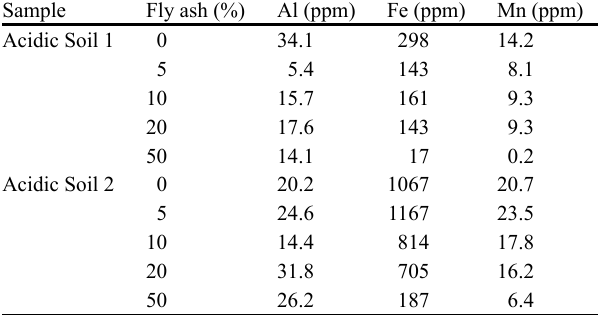
Table 4 Dissolution of dominant metal ions in